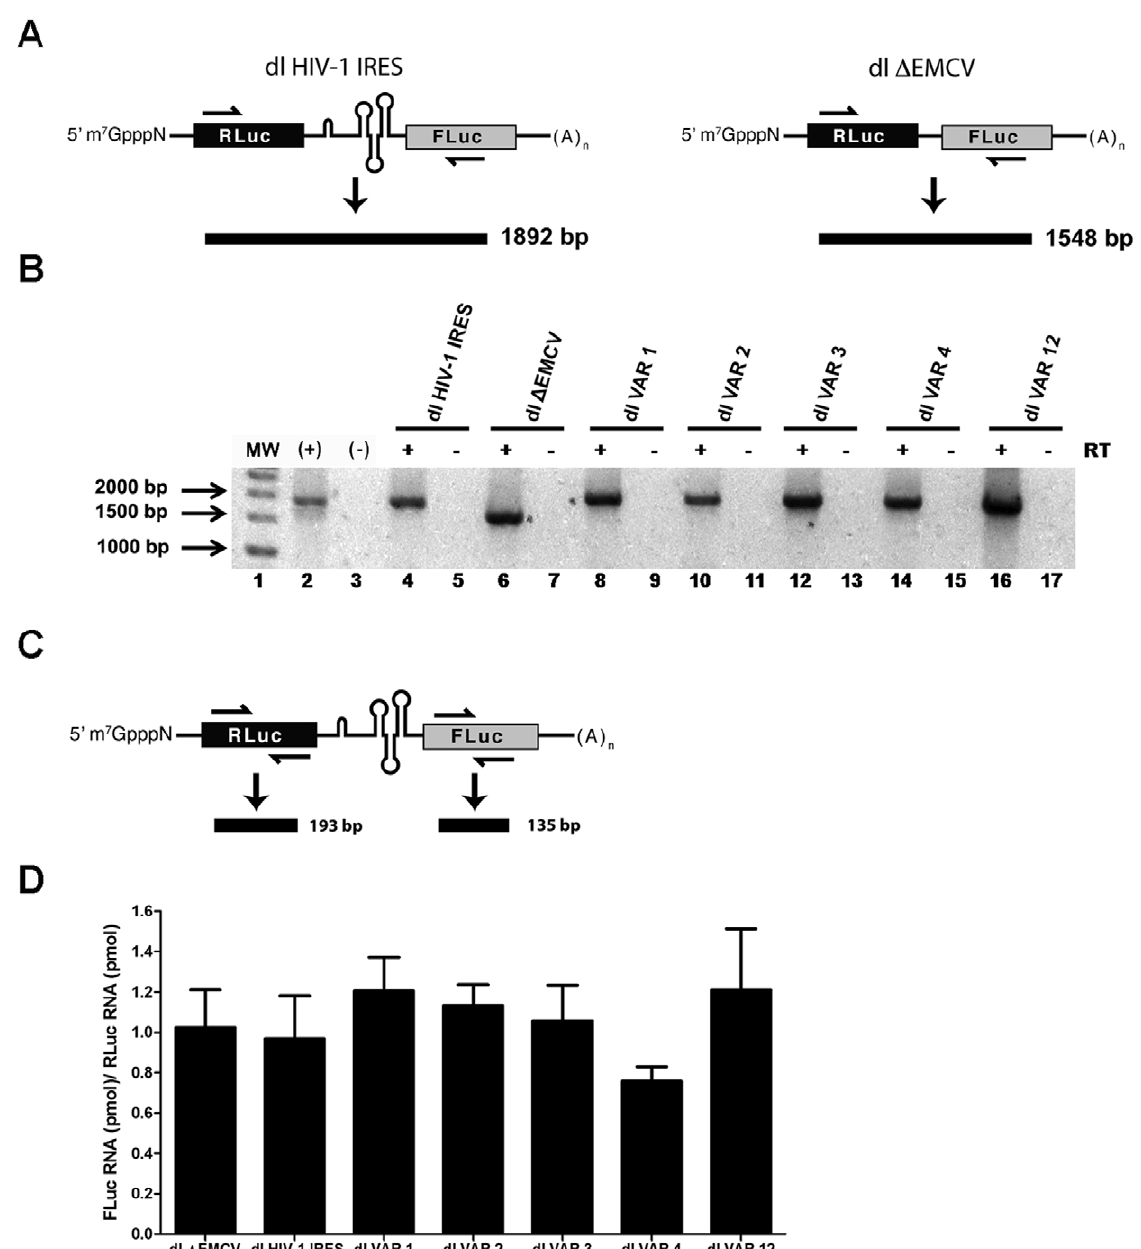
Figure 2. The full length bicistronic RNA is expressed from the dl VAR vectors. (A) Schematic representation of the experimental procedure to detect the full length bicistronic mRNA showing the primers and the size of the expected amplicons [23]. (B and D) HeLa cells were transfected with 200 ng of the dl HIV-1, dl D EMCV, or the different dl VAR plasmids. Total RNA was extracted from transfected cells and quantified. (B) Extracted RNA (3 m g) was used as template in a one-step RT-PCR designed to specifically detect the bicistronic RNAs (lanes 4, 6, 8, 10, 14, and 16). To assay for DNA contamination the same reaction was conducted in the absence of reverse transcriptase (lanes 5, 7, 9, 11, 13, 15, 17). In vitro transcribed dl HIV-1 IRES RNAs (lane 2) and water (lane 3) were included as RT-PCR controls. (C) Schematic representation of the experimental procedure to detect the RLuc-RNA and FLuc-RNA showing the primers and the size of the expected amplicons (D) Total RNA (200 ng) extracted from transfected HeLa cells was used as template in parallel RT-qPCR reactions designed to specifically detect the RLuc or FLuc containing RNAs. The RNA-FLuc concentration (pmol)/RNA-RLuc (pmol) ratio was calculated. Values are the means + /- SEM from three independent experiments (each RNA sample was amplified in three independent reactions). doi:10.1371/journal.pone.0035031.g002 reporter in Xenopus laevis oocytes. As an additional control dl eliminating the possibility of de novo RNA synthesis from a DNA D EMCV, dl HIV-1 IRES, and dl VAR DNA plasmids were template (data not shown). Together, these data provide microinjected into the cytoplasm of Xenopus laevis oocytes. In all substantial evidence supporting the presence of IRESes within the VAR 5 9 UTRs examined. Furthermore, our observations are in cases neither RLuc nor FLuc activity could be detected,